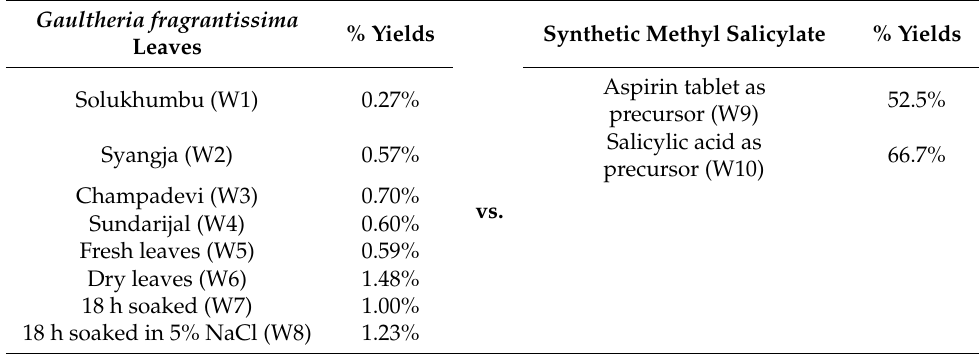
Table 1. Yields of natural wintergreen oil and synthetic methyl salicylate. Gaultheria fragrantissima Leaves